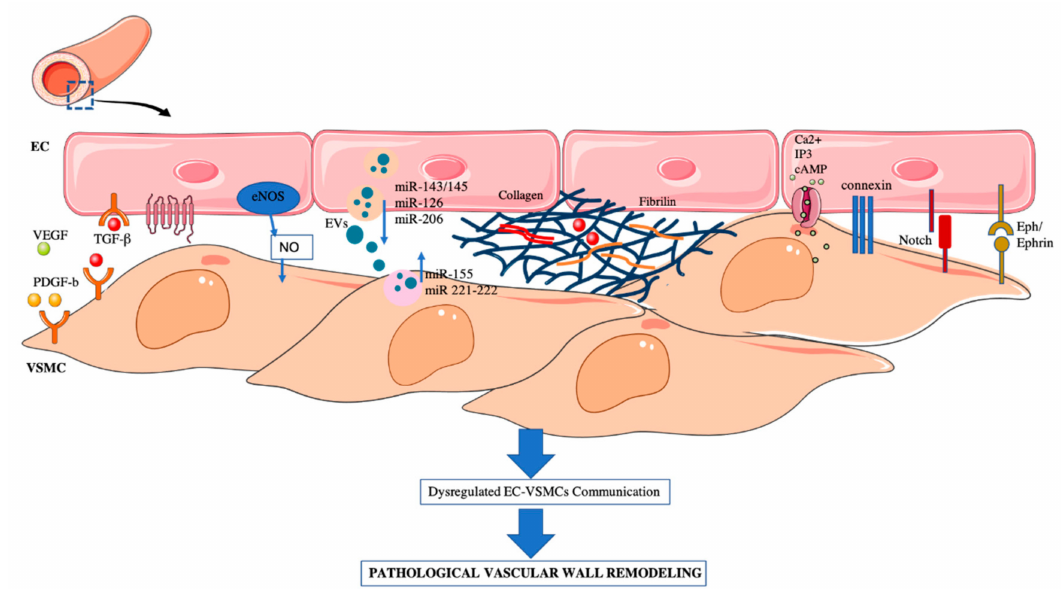
Figure 1. EC–VSMCs communication in a vessel wall. Schematic representation of: paracrine, extracellular vesicles, ECM and direct cell–cell interaction. Dysregulation of EC–VSMC communication triggers the pathological vascular wall remodeling associated to some